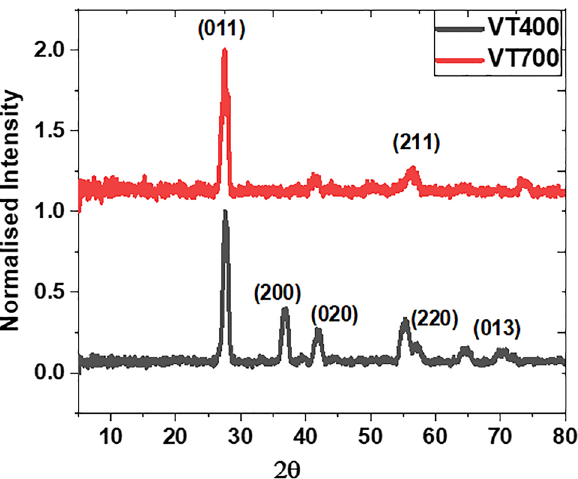
Figure 4. XRD diffraction patterns spectra of the VO 2 thin films fabricated at different substrate temperatures 400 °C (VT400) and 700 °C (VT700).